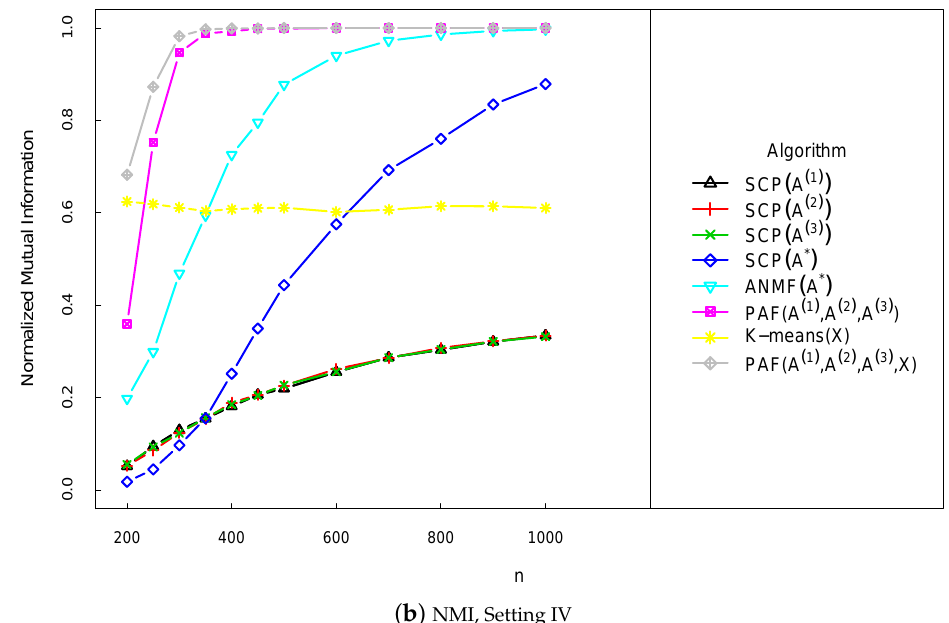
Figure 2. The two panels present the NMI results for Setting III (undirected multi-layer SBM) and Setting IV (directed multi-layer SBM),